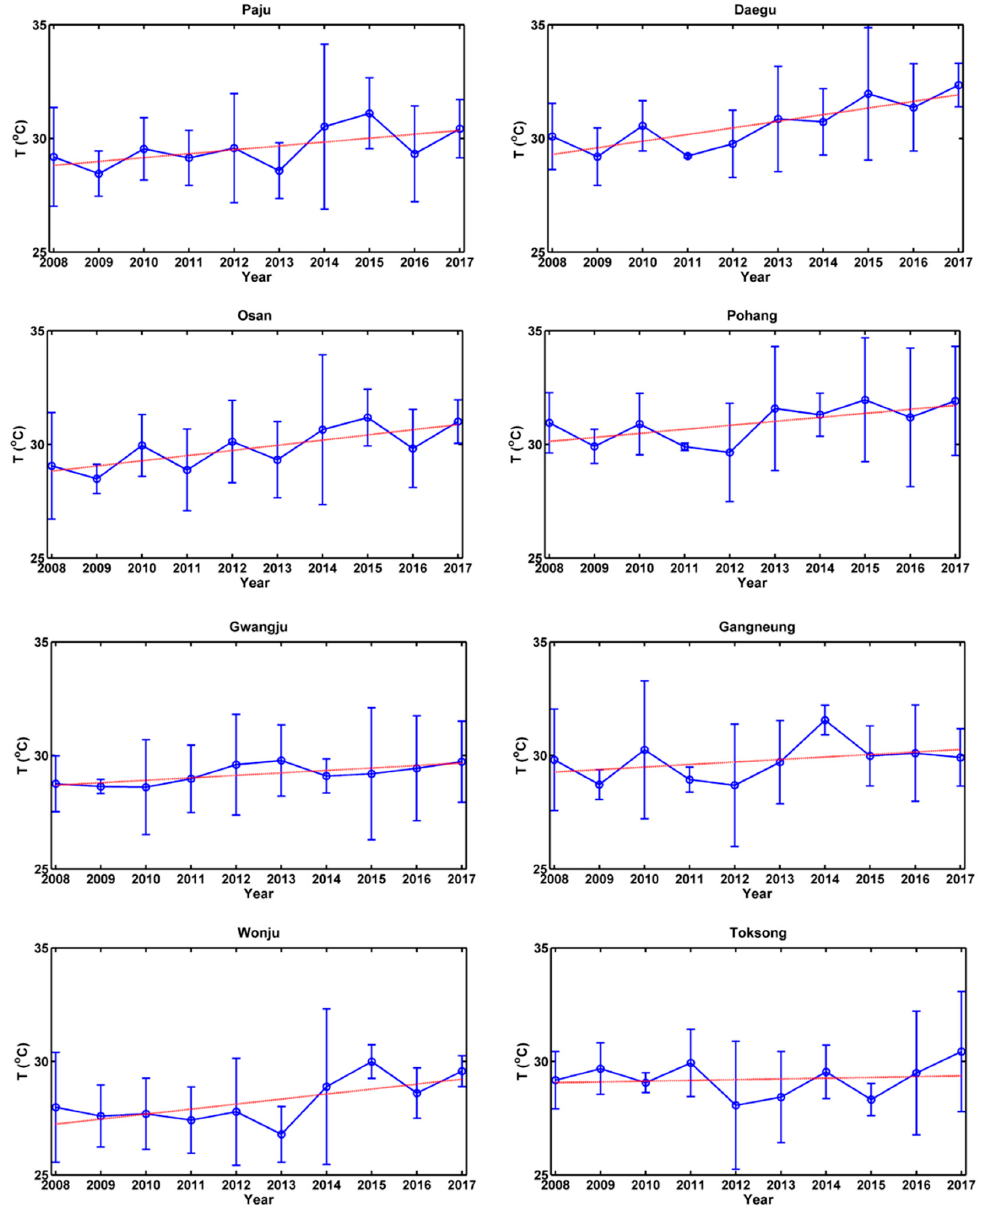
Figure 10. Variability of the maximum surface temperature during summer from 2008 to 2017. The error bars and dashed red lines indicate the standard deviation and linear fit of the data, respectively.